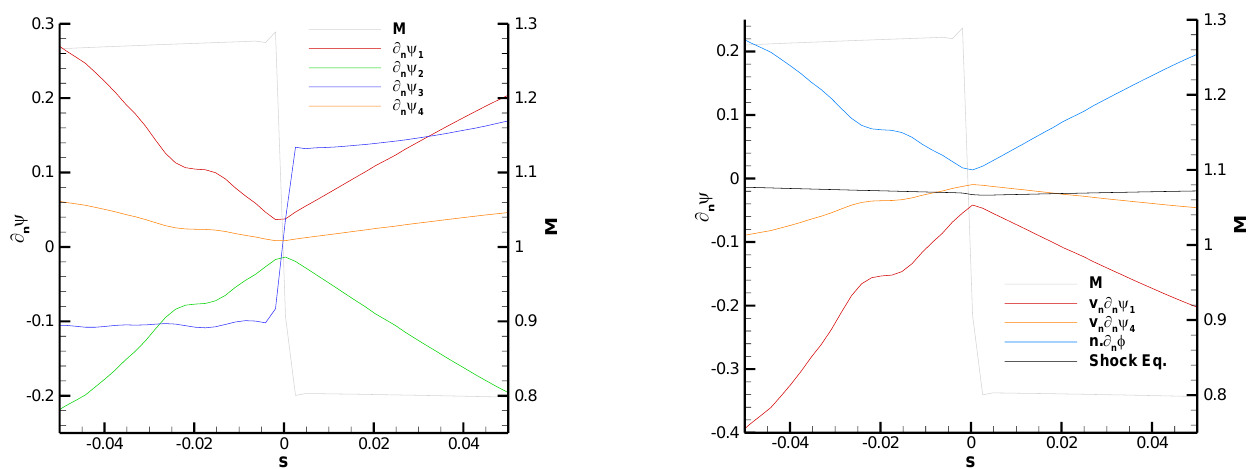
Figure 14. Flow past a NACA0012 airfoil at M = 0.8 and α = 1.25°. Adjoint normal derivatives and shock relations across the shock.